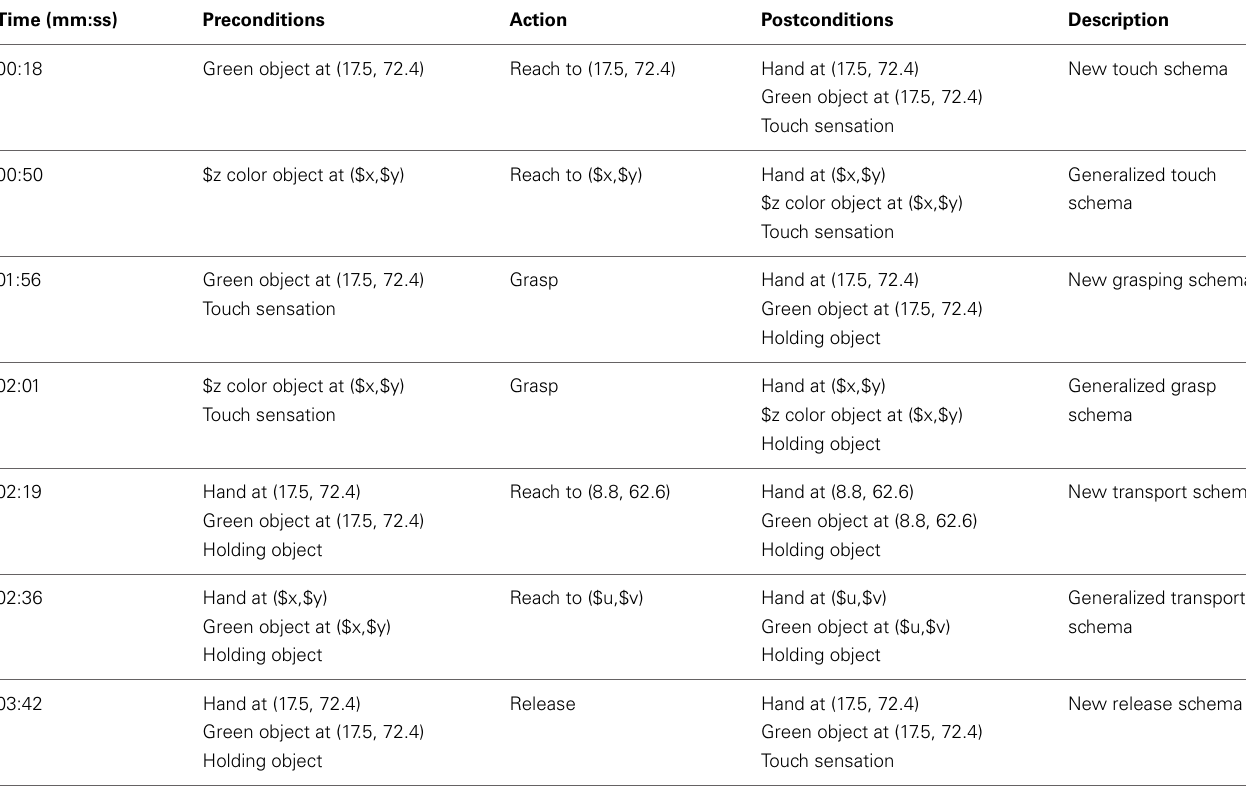
Table 11 | Schema discovery on the